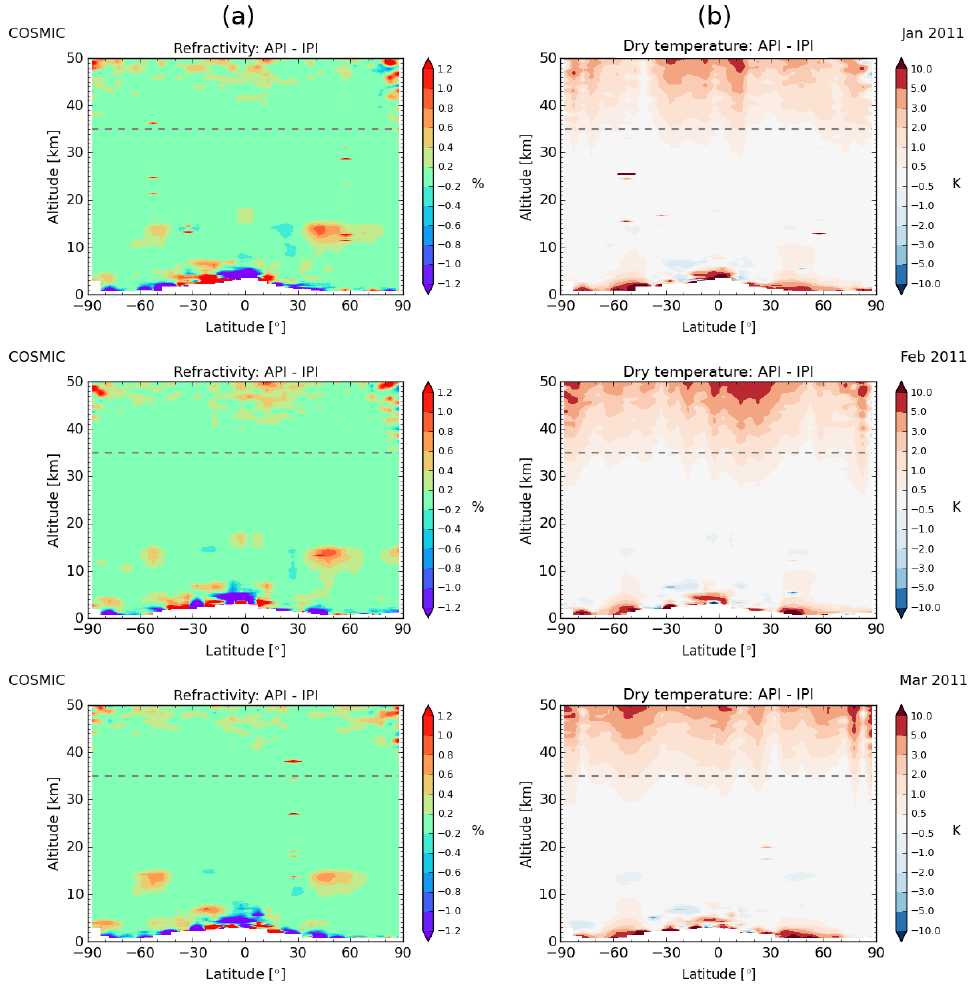
Figure 3. WEGC: difference between API and IPI climatologies, analyzed for refractivity (a) and dry temperature (b) , using L1b WEGC bending angles as input, studied from January to March 2011 (top to